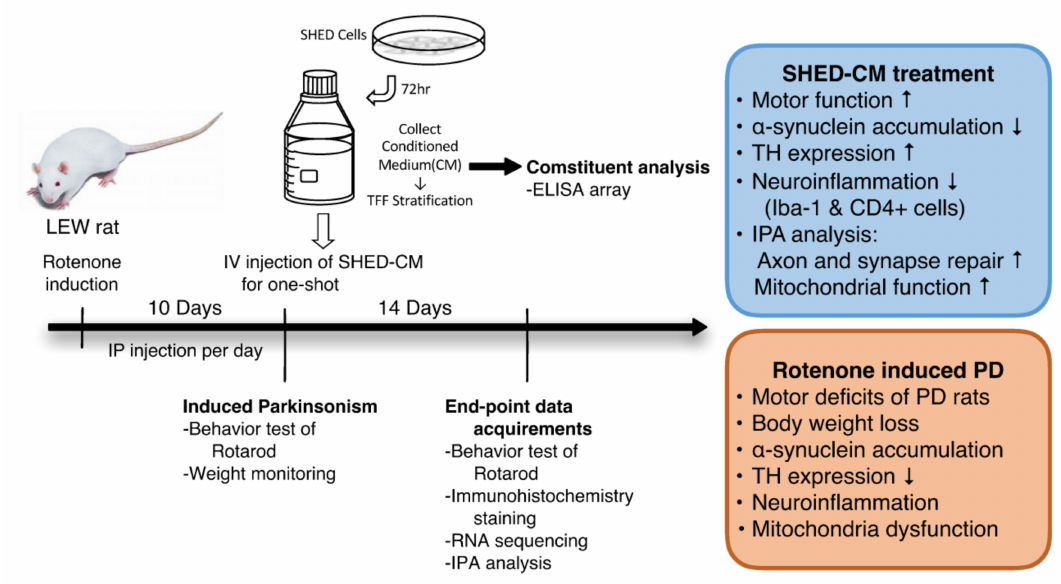
Figure 7. Illustrative scheme for the bioavailability of SHED-CM that can improve neuroinflammation, α -synuclein clearance, mitochondrial repair, and motor dysfunction. The rotenone-induced model exhibitedmotordysfunctionthatrecapitulatestheclinicalsymptomsofPD.AdministrationofSHED-CM showed promising e ffi cacy that improves impaired mitochondrial dysfunction, overwhelming neuroinflammation, and various neurological deficits in this PD